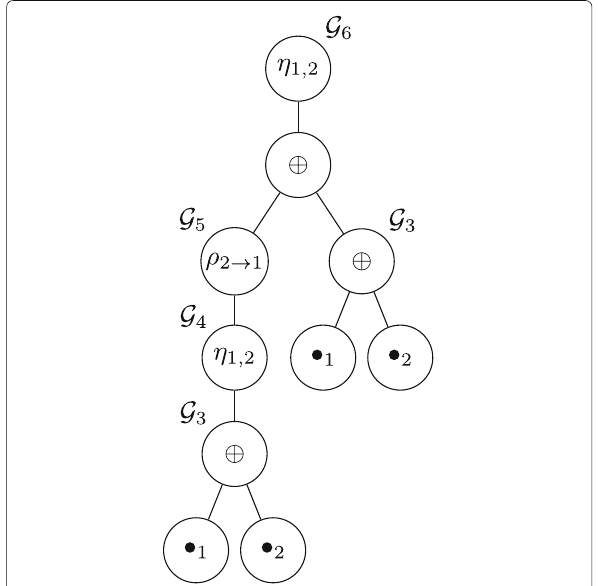
Fig.4 CW 2 -expressions and their corresponding 2-labeled graphs [20]